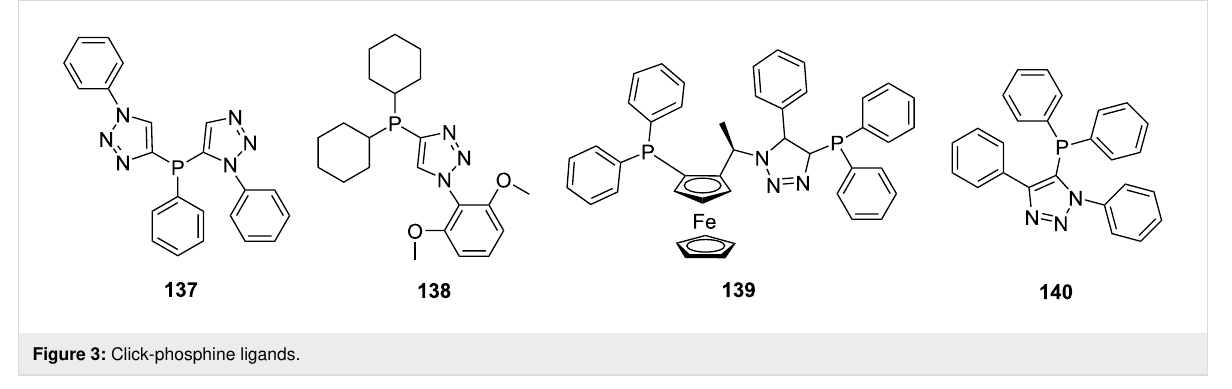
Figure 3: Click-phosphine ligands.